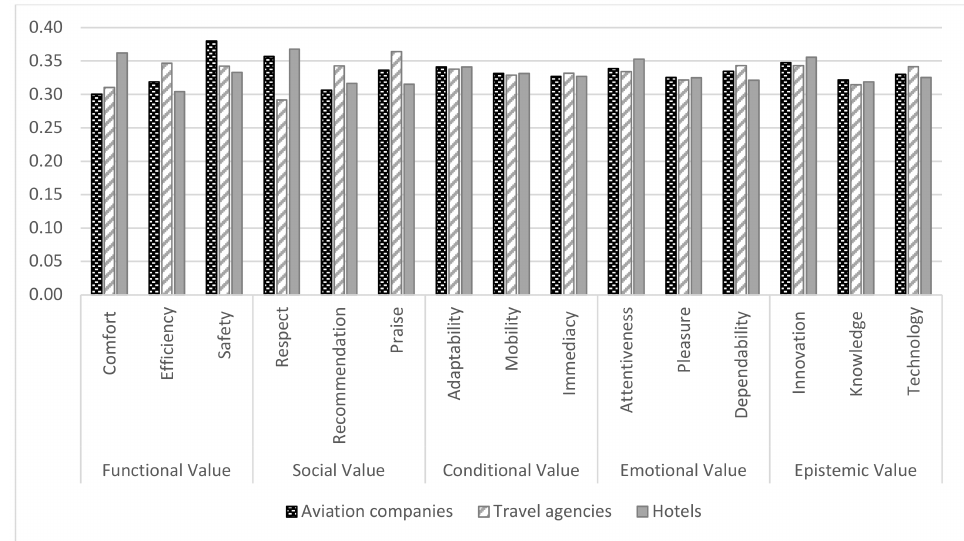
Figure 4. Weights comparison of the service quality aspects in the three industries.